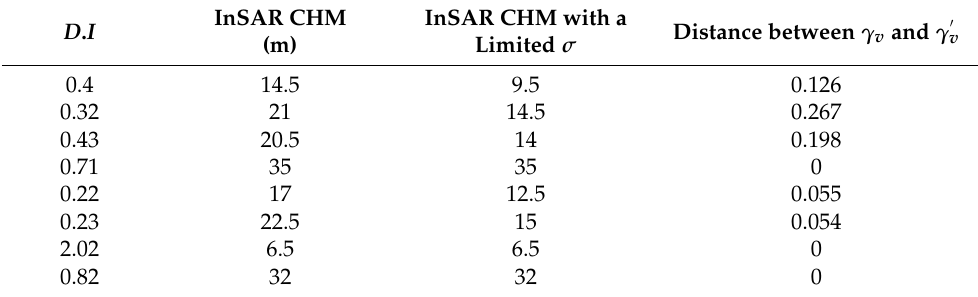
Table 2. Comparison of the CHMs before and after using the limited extinction